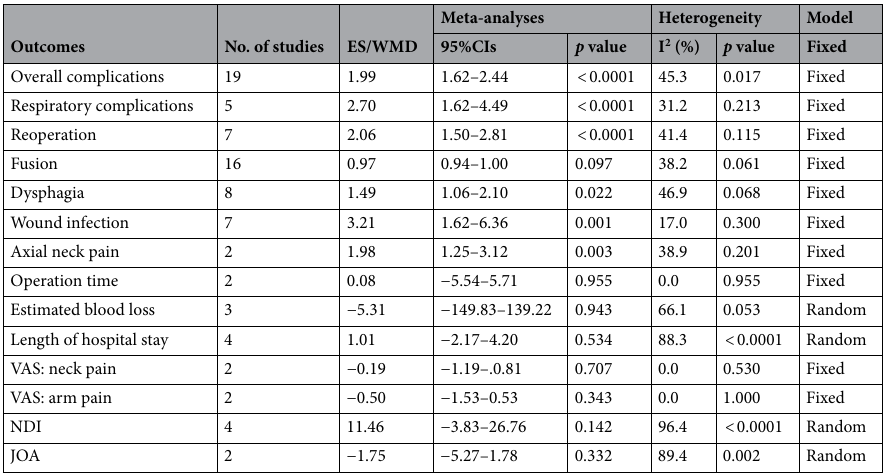
Table 4. Results of the meta-analysis. Cis confidence intervals, ES effect estimate, WMD weighted mean